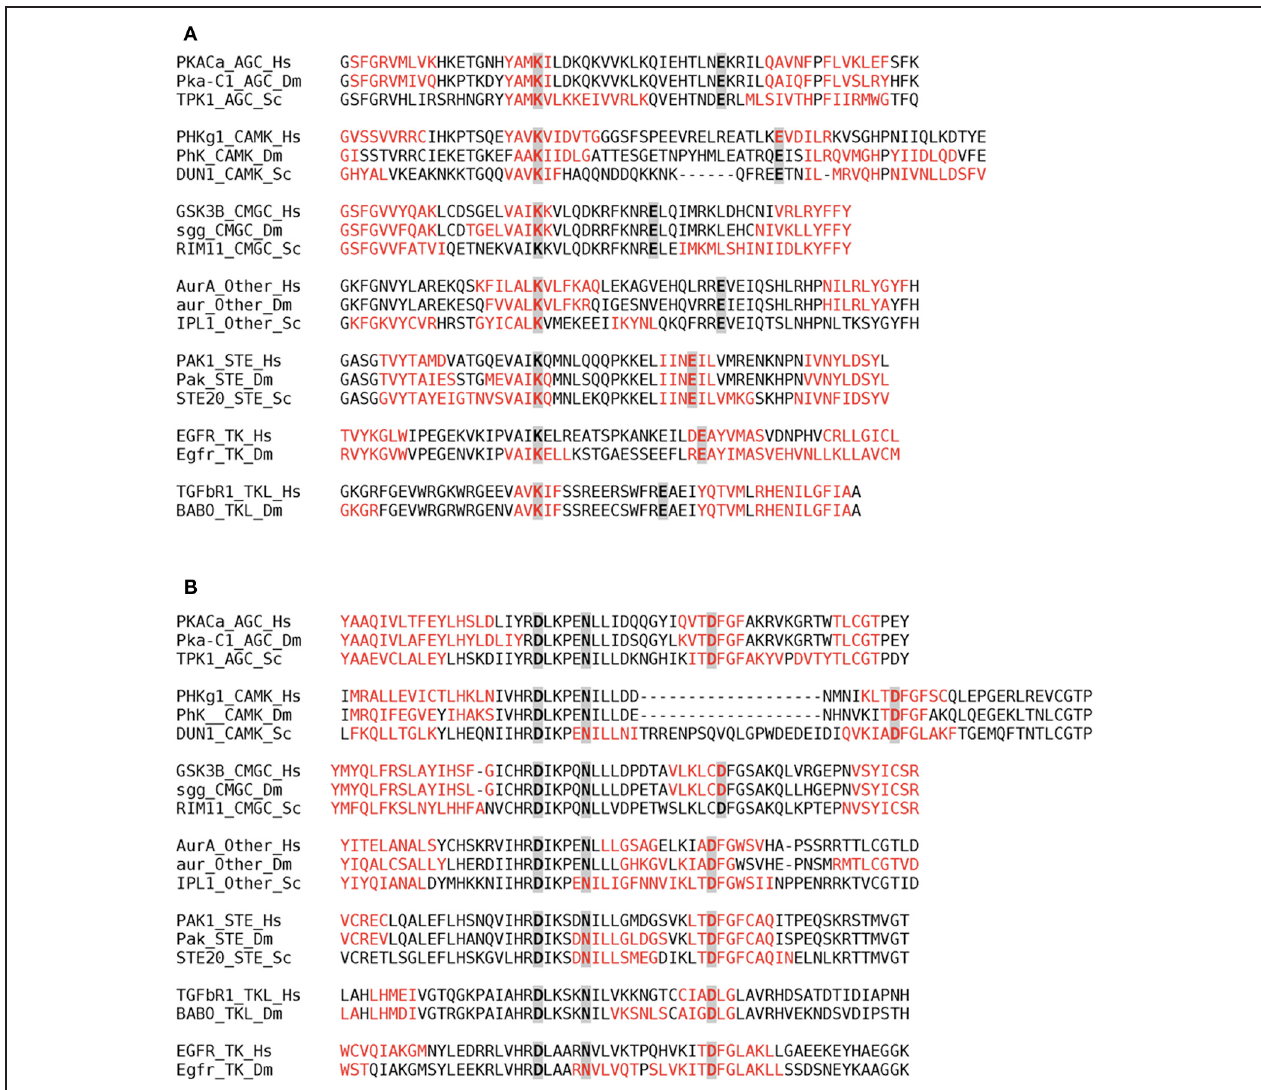
FIGURE 11 | Aggregation-prone regions detected by AGGRESCAN within the 20 amino acids flanking the Nter and Cter sides of the first (A) and second (B) regions containing conserved catalytic residues in kinase domains. Aggregation-prone stretches are shown in